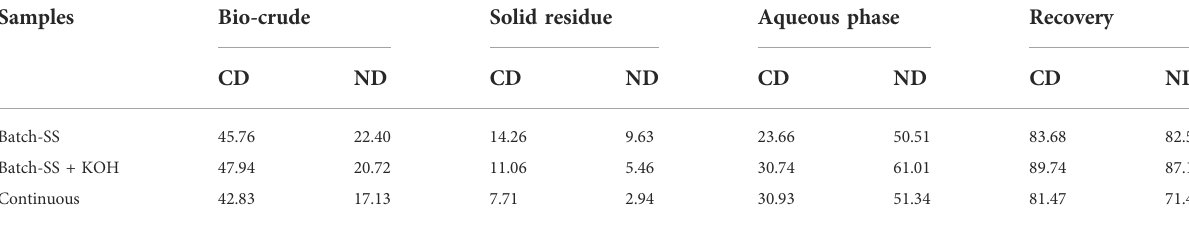
TABLE 8 Comparison of elemental distributions (wt%) across various products from batch and continuous HTL of sludge at 350 ° C with 8 min RT (retention time).